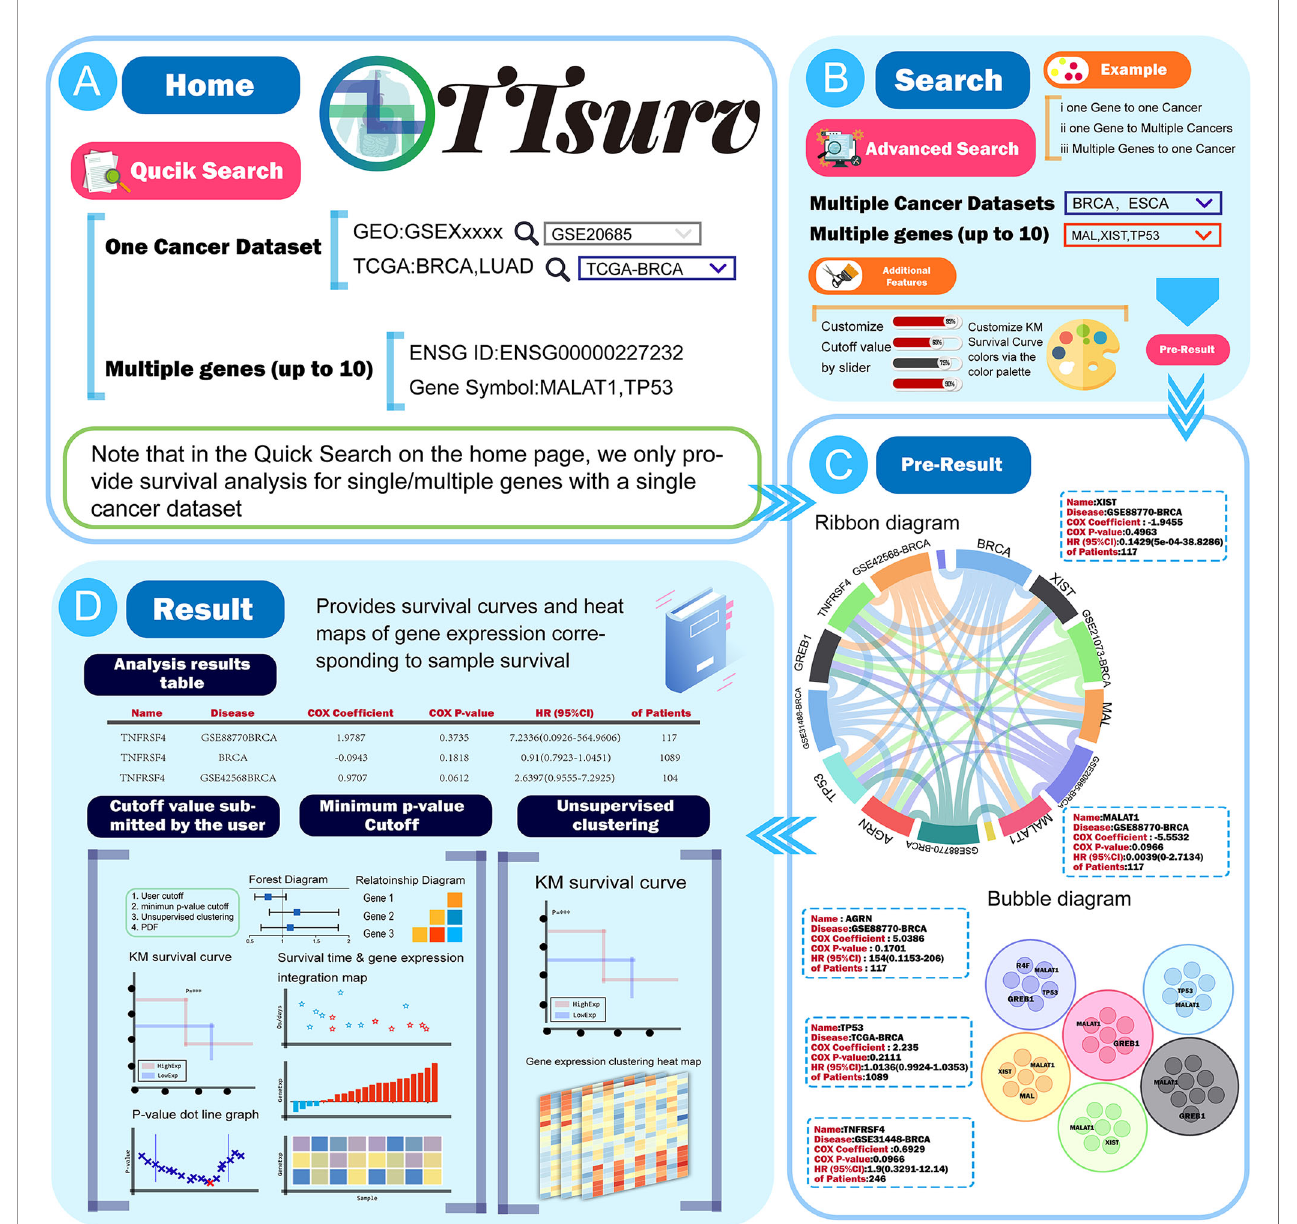
FIGURE 2 | The use process and a demonstration of the results provided by TTSurv. (A) The data source for TTSurv and the usage of QucikSearch. (B) Introduction to advanced search in the search interface. (C) Two kinds of charts in Pre-Result, where users can get the analysis results by clicking parts of the chart. (D) Schematic diagram of the data table and images in the result